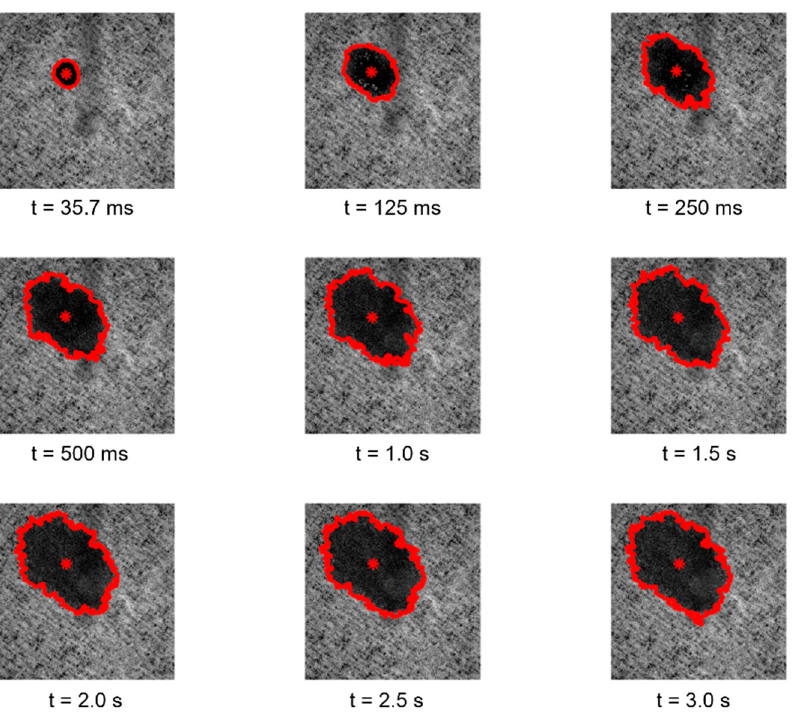
Figure 14. Spreading dynamics of a liquid droplet from t = 35.7 ms to 3 s for the tissue-paper sample Bm rd .